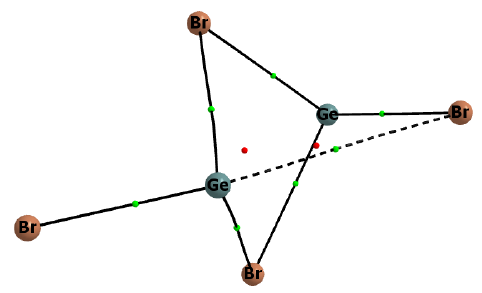
Figure 5. The molecular graph of (GeBr 2 ) 2 ; big circles correspond to the attractors (grey—germanium, brown—bromine), small green circles to the bond critical points and red circles to the ring critical points; solid and broken lines indicate bond paths.